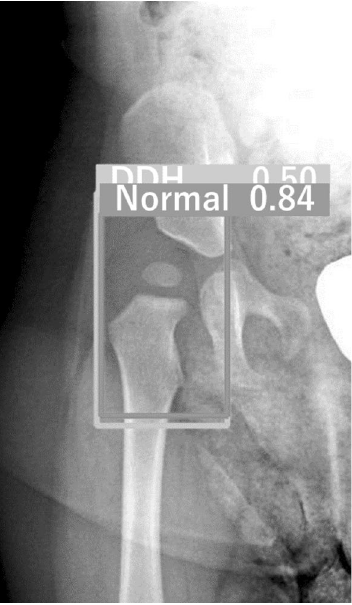
Figure 3. Example of double labeling. The right hip was labeled as both “Normal” and “DDH”. DDH Developmental dysplasia of the